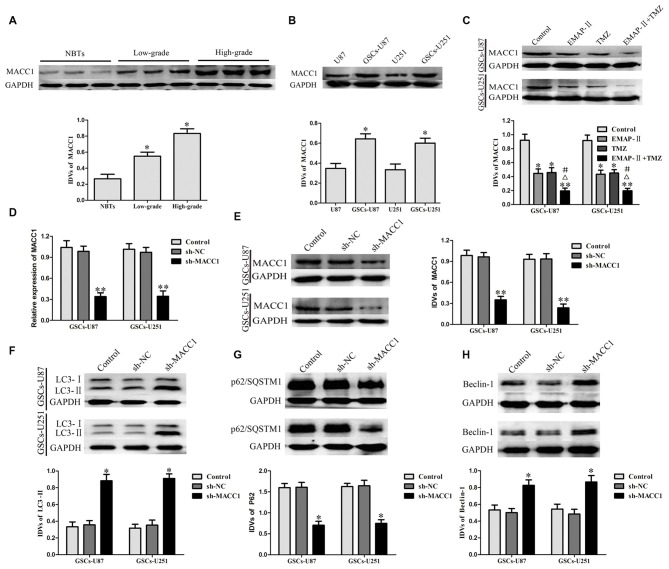
Metastasis-associated in colon cancer 1 (MACC1) acted as an oncogenic role in glioma tissue and GSCs. (A) MACC1 protein expression levels in nontumorous brain tissues (NBTs), low-grade glioma tissues (World Health Organization [WHO] I–II), and high-grade glioma tissues (WHO III–IV). Data are presented as the mean ± SD (n = 3, each group) *P < 0.05 vs. NBTs group. (B) MACC1 protein expression levels in U87, U251 and GSCs. Data are presented as the mean ± SD (n = 5, each group) *P < 0.05 vs. non-GSCs group. (C) Western blot assay was performed to detect the expression of MACC1 in GSCs treated with EMAP-II, TMZ or EMAP-II + TMZ. Data are presented as the mean ± SD (n = 5, each group) *P < 0.05 vs. Control group, **P < 0.01 vs. Control group, #P < 0.05 vs. EMAP-II group, ΔP < 0.05 vs. TMZ group. MACC1 knockdown induced GSCs autophagy. (D,E) The knockdown efficiency of MACC1 by shRNA were detected by qRT-PCR and Western blot assay. (F–H) Western blot analysis was performed to detect the expression of autophagy-related genes. Data are presented as the mean ± SD (n = 5, each group) *P < 0.05 vs. sh-NC group. Data are presented as the mean ± SD (n = 5, each group) *P < 0.05 vs. sh-NC group, **P < 0.05 vs. sh-NC group.